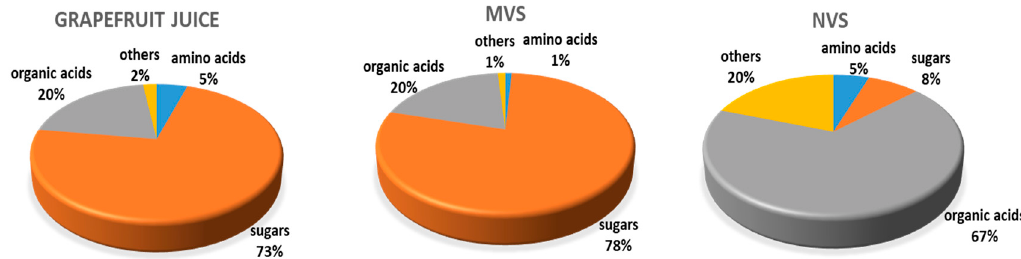
Figure 4. Distribution of main metabolite classes identified in grapefruit juice, and microvesicle and nanovesicle samples. Nanovesicles exhibit a high relative amount of amino acids and organic acids, while microvesicles and fruit juice are characterized by a high percentage of carbohydrates and derivatives. Table 1. Top ranking metabolites tentatively-identified in grapefruit ( A ) fruit juice, ( B ) MVs and ( C ) NVs.